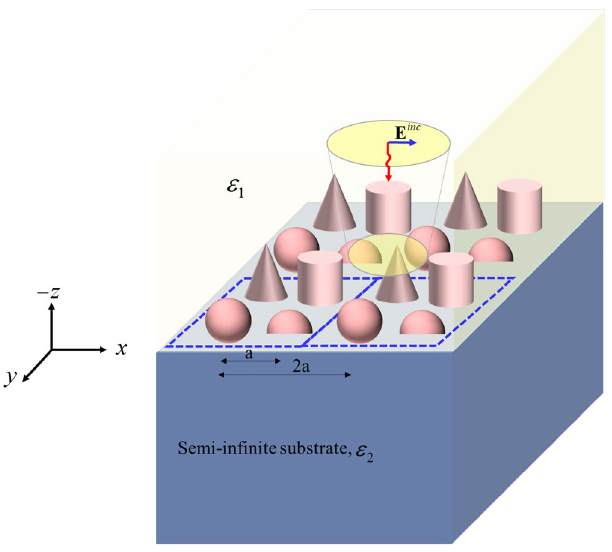
Figure 1. A general inhomogeneous metasurface sandwiched between two dielectric